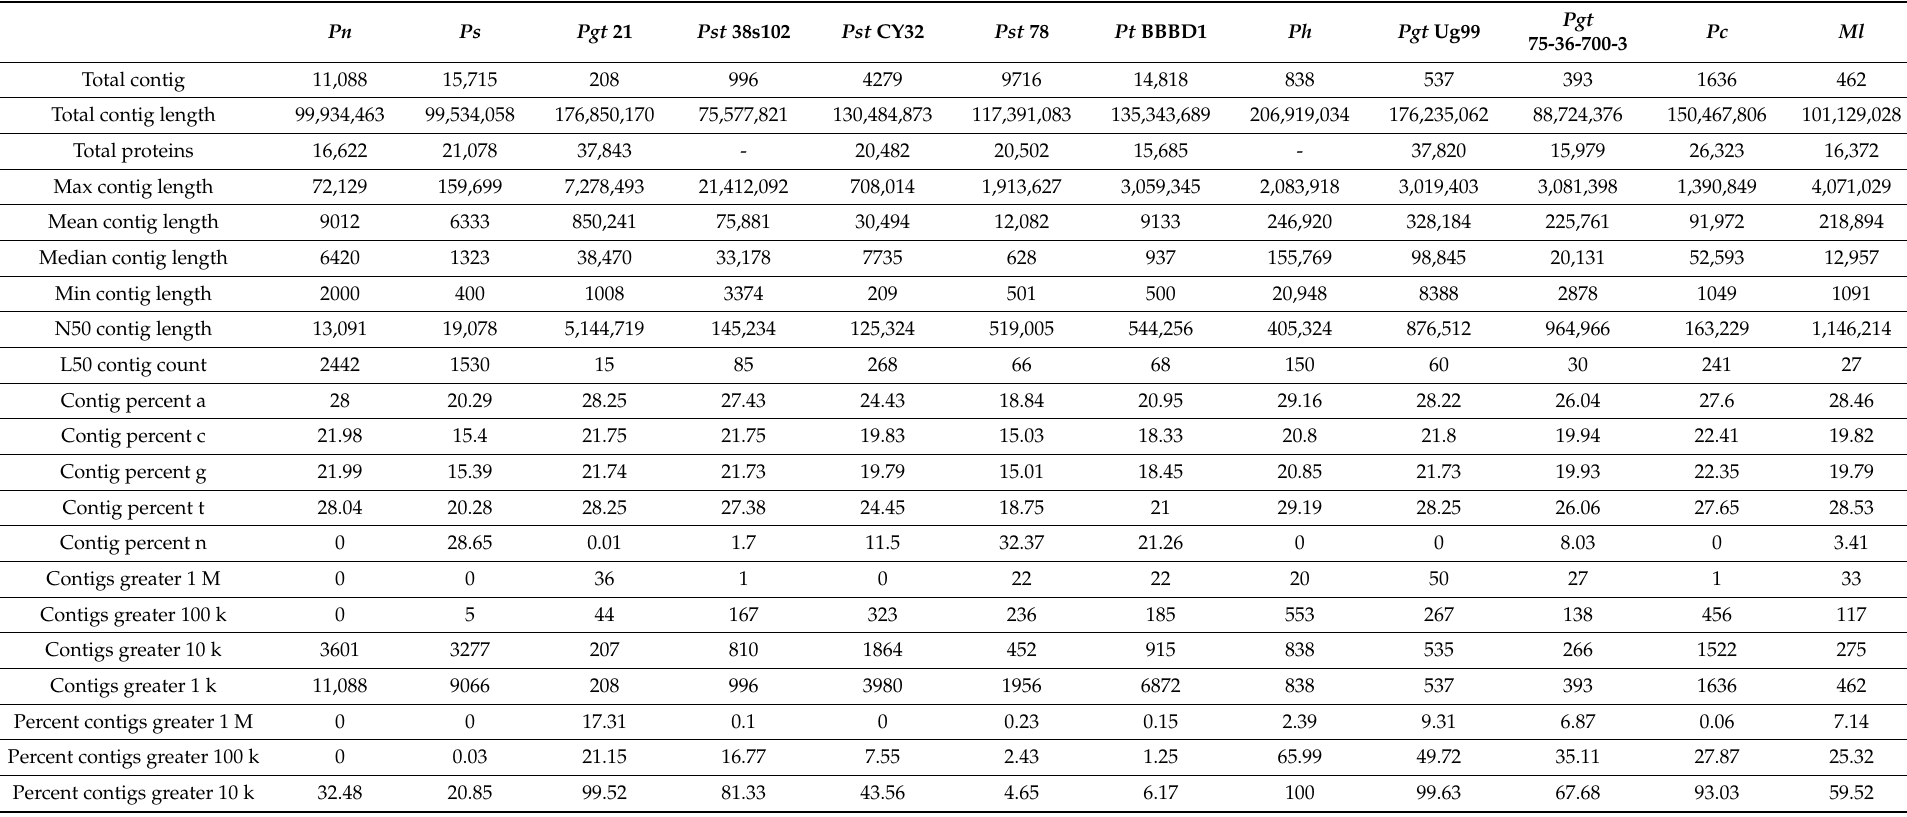
Table 1. Comparison metrics of rust pathogen